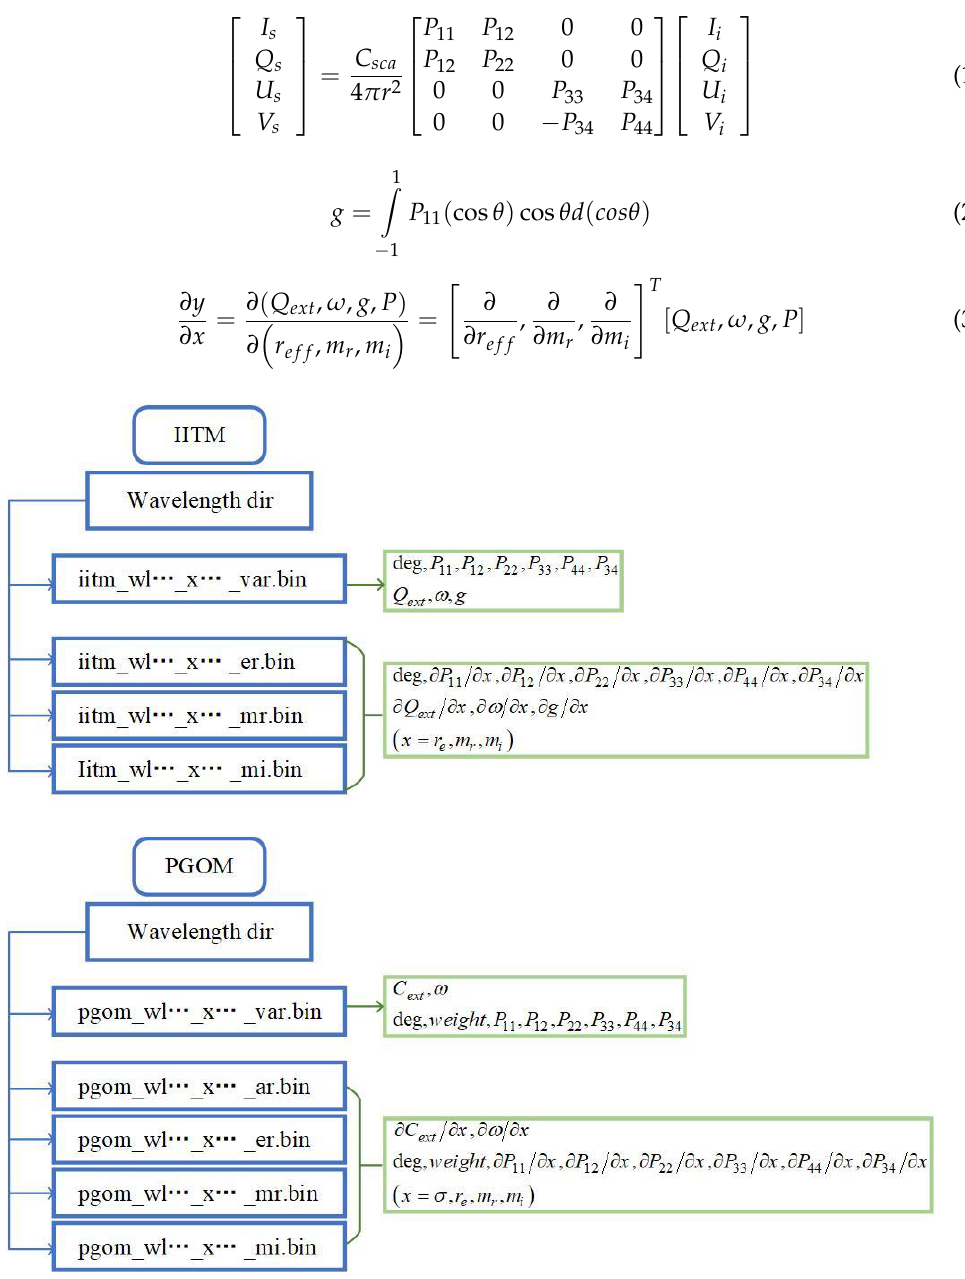
Figure 4. Structure of the database. The blue boxes show the file names and directory (abbreviated as “dir”), and the green boxes show the variables contained in each file.